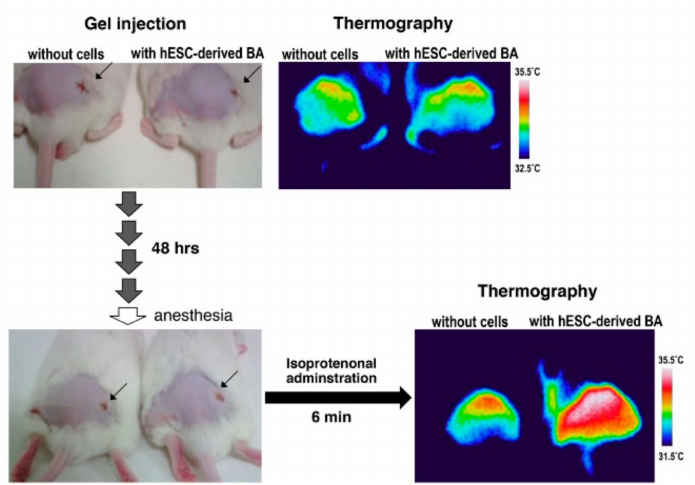
Figure 8. BAs generated from hESCs under cytokine-free conditions produce heat in vivo in response to adrenergic stimuli. hESCs (KhES-1) were subjected to di ff erentiation into BA by the cytokine-free method. After being embedded in fibrin gel, BAs were subcutaneously transplanted into mice. For control, gel without cells was transplanted. After 48 h from transplantation, isoproterenol, a beta-adrenergic receptor agonist, was injected from tail vein and dermal temperature was followed up under infrared camera observations. After several minutes from isoproterenol injection, dermal temperature around the transplanted region was up-regulated specifically in BA-transplanted mice.